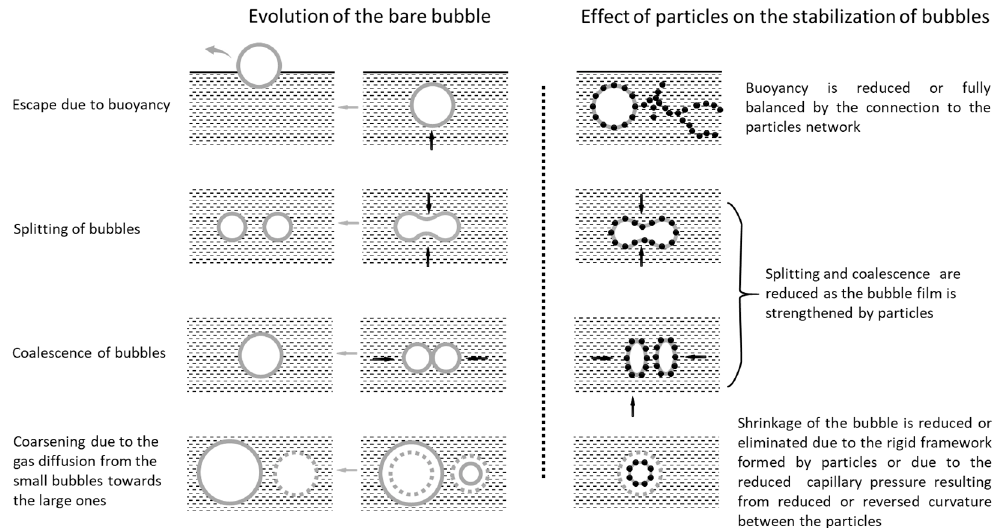
ff ects of particles on the stabilization of Figure 1. Schematic of the effects of particles on the stabilization of bubbles. Figure 1. Schematic of the e